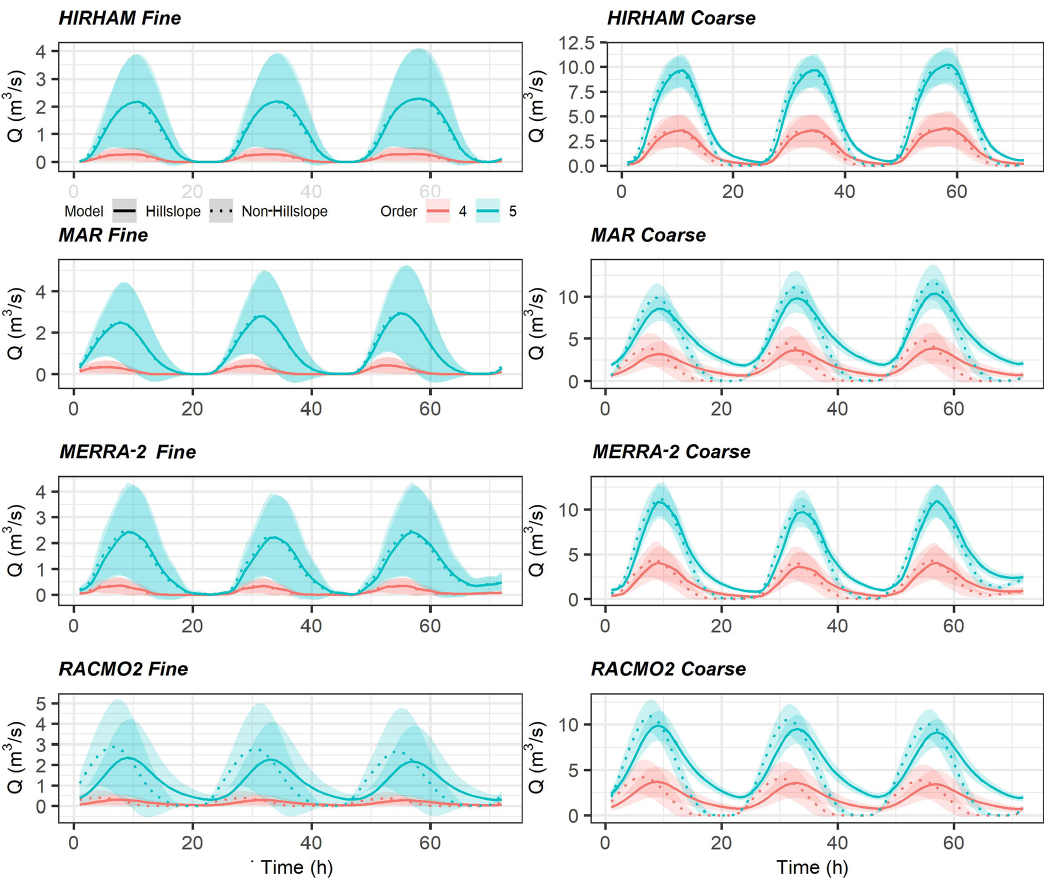
Figure 6. As Fig. 5 but for 4th and 5th orders. Note the increase by a factor of ∼ 2 in flows between fine and coarse networks and the reduction in variability in coarse network flows. As before, the shaded areas represent variability, not